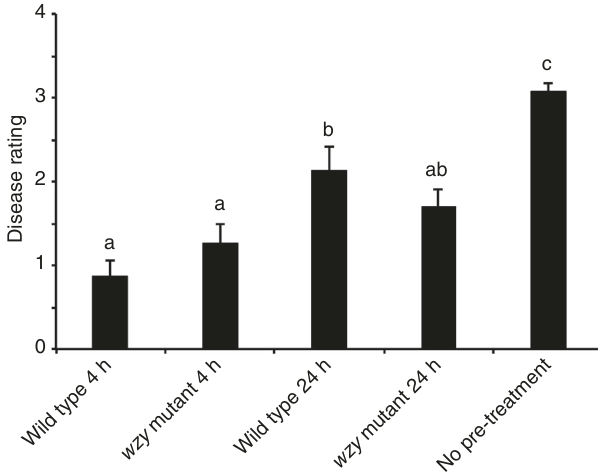
Fig. 5 Pierce ’ s disease symptom severity in grapevines primed with puri fi ed Xf LPS. Average disease ratings of V. vinifera ‘ Cabernet Sauvignon ’ grapevines pre-treated with wild type or wzy LPS, or a water negative control, then challenged at 4 h or 24 h post-LPS treatment with live Xf cells. Disease ratings were taken at 12 weeks post-challenge. The LPS pre-treated plants are signi fi cantly attenuated in symptom development, compared with plants that did not receive pre-treatment. Graph represents the mean of 24 samples per treatment. Error bars indicate ± standard error of the mean. Treatments with different letters over the bars are statistically different ( P < 0.05, Student ’ s t -test, n = 24 per treatment)